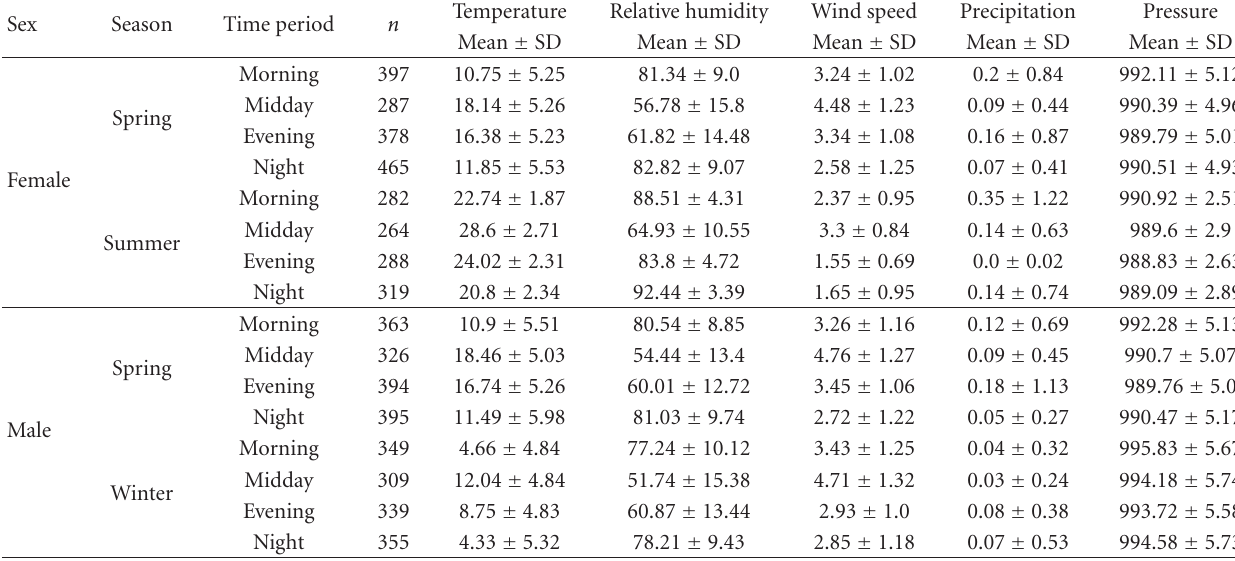
Table 3: Means ( ± SD) of temperature ( ◦ C ), relative humidity (%), wind speed (m/sec), precipitation (mn), and pressure (millibars) during each respective season and time period. Means ± SD were used to compare movements during extreme weather events.